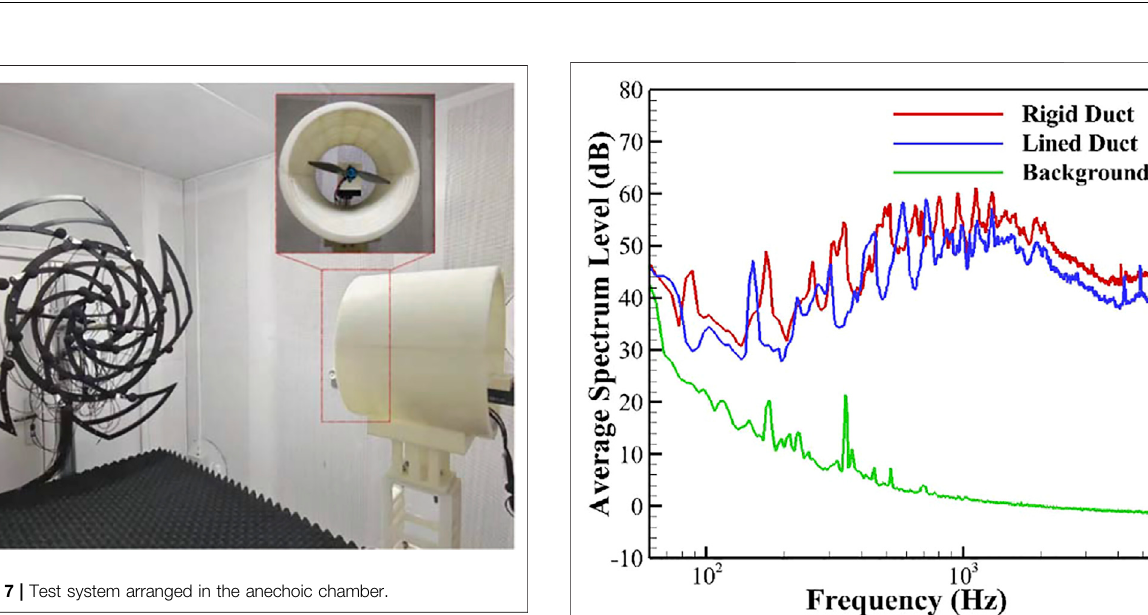
FIGURE 6 | (A) Photograph of the microphone array and (B) sketch of microphone position.